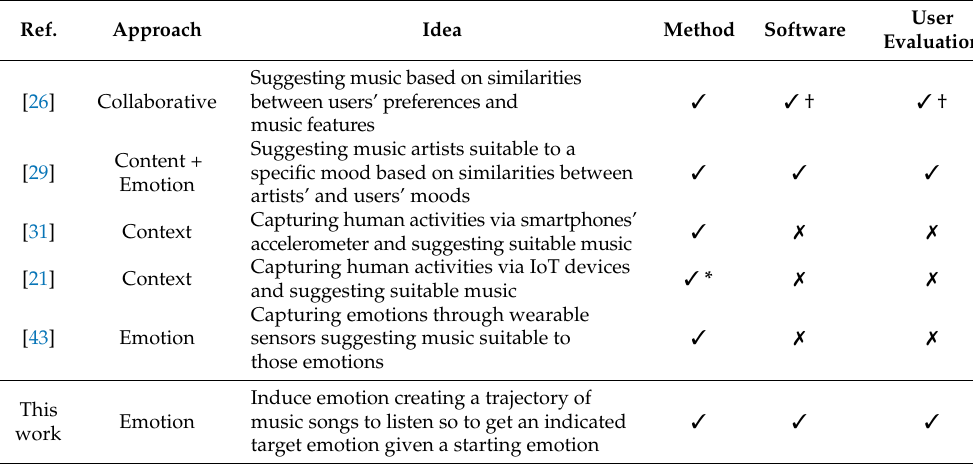
Table 1. Main points of both closest articles in the literature and this work. † = lacking details. * = framework.